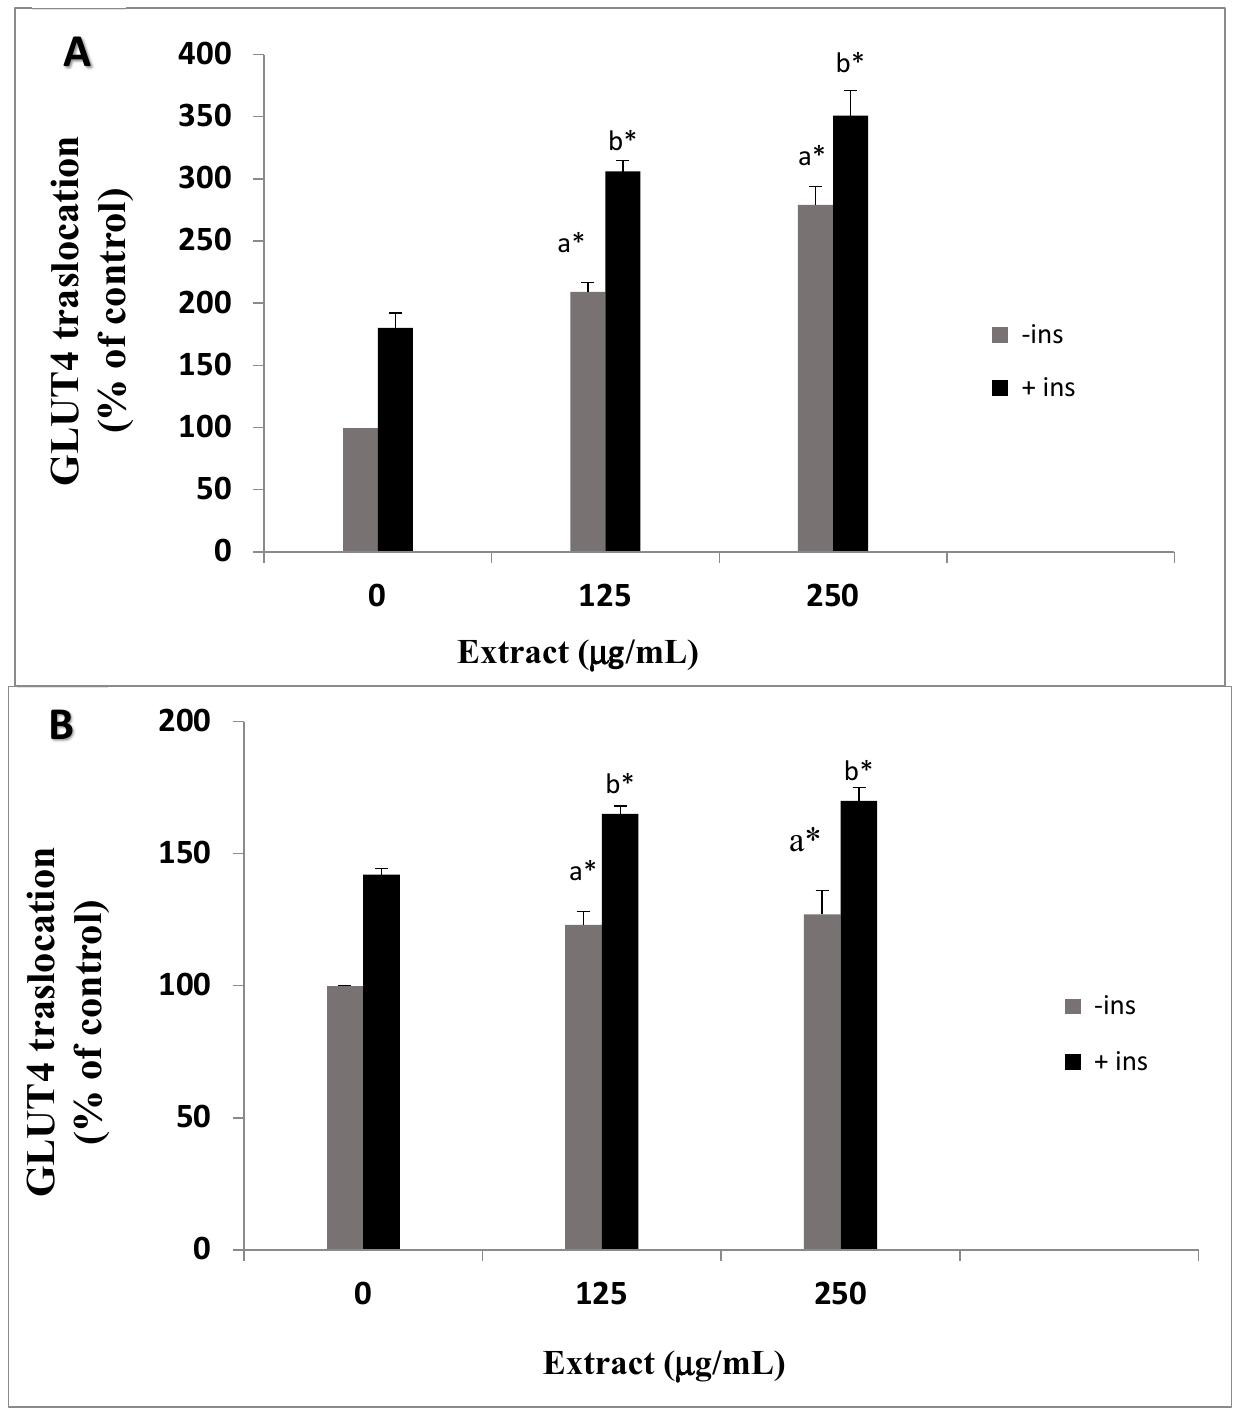
Figure 2. GLUT4 translocation to the plasma membrane. L6-GLUT4myc cells (150,000 cell/well) were seeded in a 24-well plate and were exposed to WOS ( A ) and MOS ( B ) without ( − ) or with (+) insulin as described in the methods. Surface myc -tagged GLUT4 density was quantified using the antibody coupled colorimetric assay. Values given represent means ± SEM (relative to untreated control cells) of three independent experiments carried out in triplicates. Statistical significance: (a) compared with (-ins) control group, (b) compared with (+ins) control group.